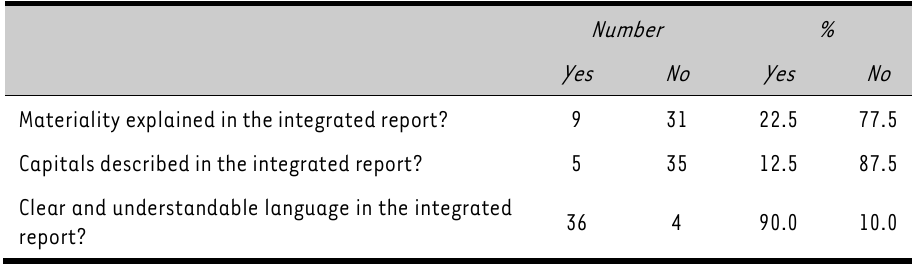
Scope and boundary